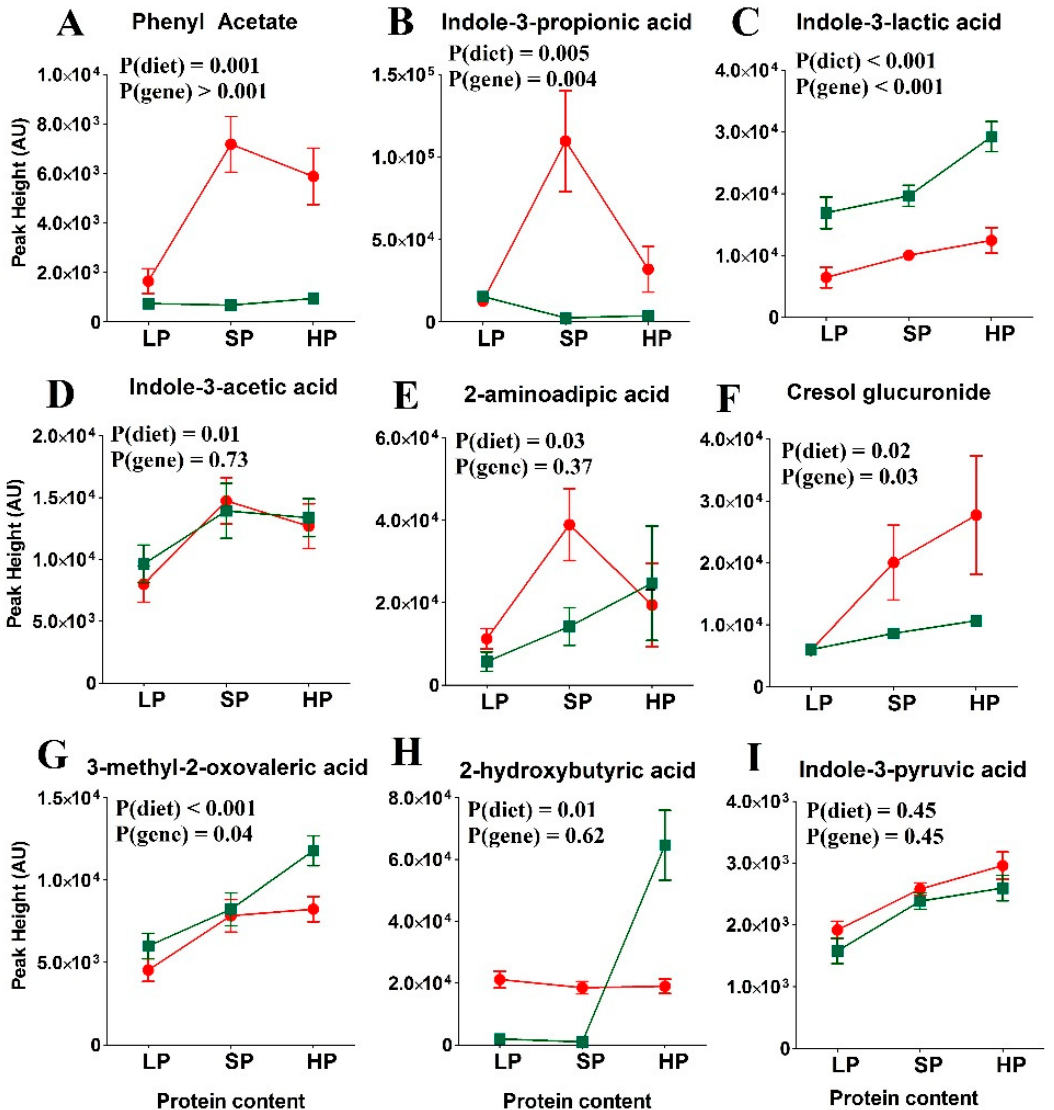
Figure 4. Abundance of amino acid-derived metabolites in SLC6A19 ko (red) and wt (green) mice in the postprandial state on diets with low (LP), standard (SP), or high protein (HP) contents. Amino acid-derived metabolites: (A) Phenyl acetate, (B) Indole-3-propionic acid, (C) Indole-3-lactic acid, (D) Indole-3-acetic acid, (E) 2-aminoadipic acid, (F) Cresol glucuronide, (G) 3-methyl-2-oxovaleric acid, (H) 2-hydroxybutyric acid and (I) Indole-3-pyruvic acid. Amino acid-derived bacterial metabolites showed an increase in abundance in SLC6A19 ko compared to wt mice. The data points represent x ± SEM ( n = 5 per group). p -values were calculated by ANOVA comparing within-group and between-group variance of the diet e ff ects (diet) and genotype e ff ects (gene).